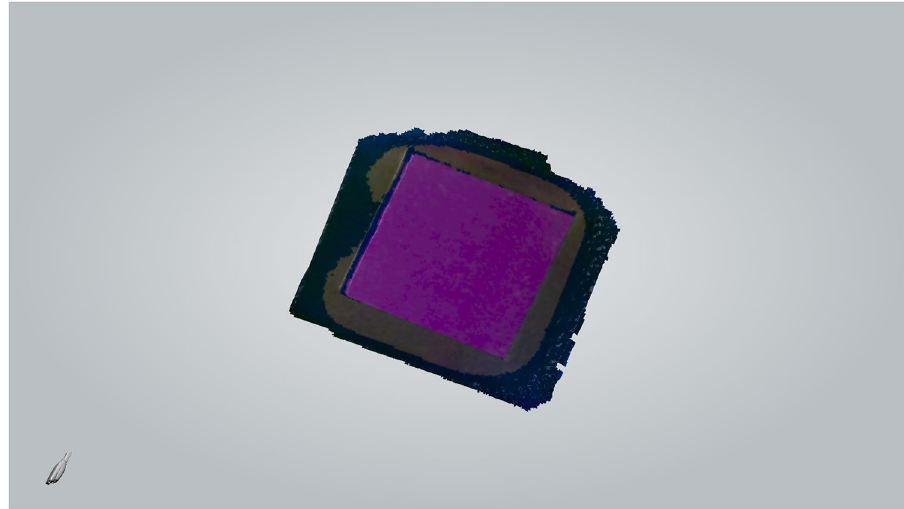
Figure 3. Colour patch digitized by the intra oral scanner.